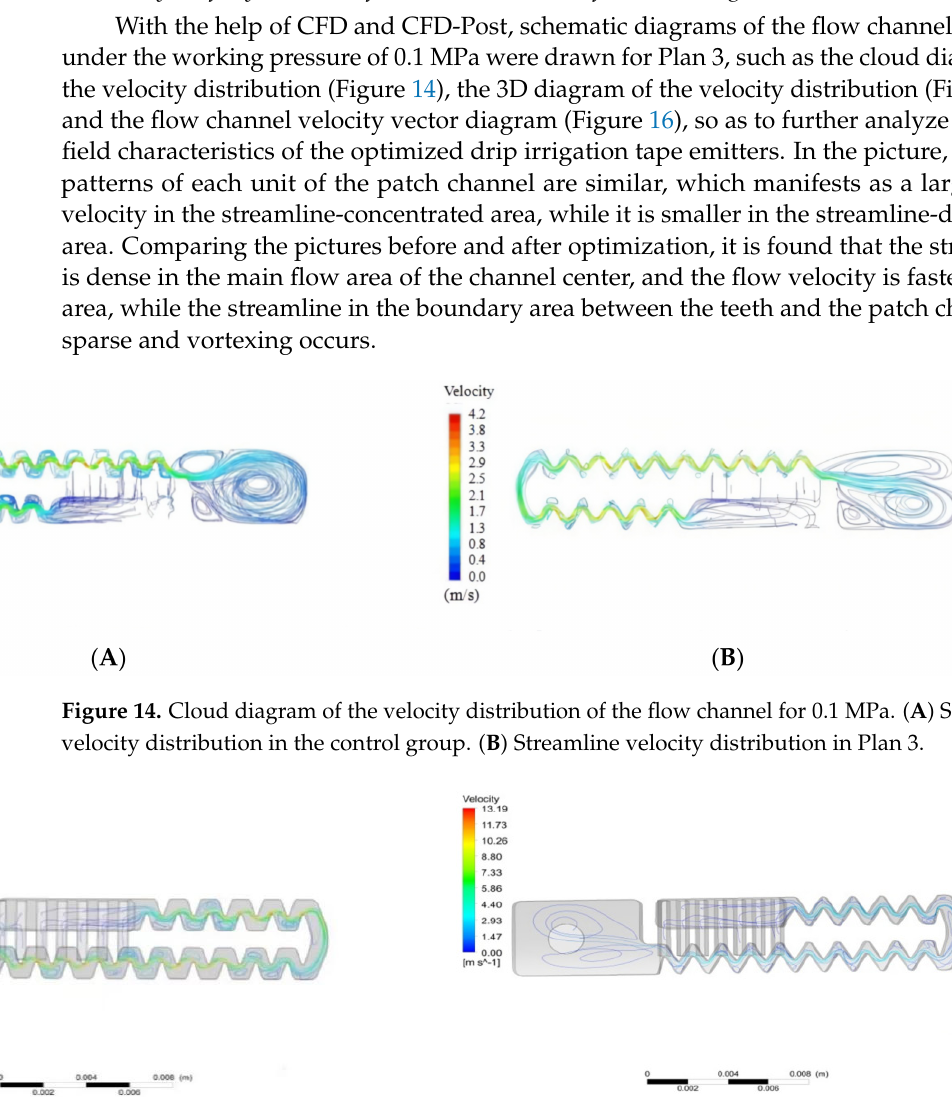
Figure 16. Velocity vector diagram of the flow channel for 0.1 MPa. ( A ) Control group (before opti- mization). ( B ) Plan 3 (after optimization). 5.4. A Summary of Performance Analysis for New Designed Emitters From the analysis of the hydraulic performances and energy dissipation perfor- mances in the all plans, it could be found that the smaller the tooth spacing was, the better the hydraulic performance of the channel was, and the lower the energy dissipation per- formance. According to the comparison of the flow index and average flow rate of the emitters in the three plans, the decrease of the flow index was smaller than the increase of the average flow rate of the emitters in Plans 1 and 2, and the change ratios of the two param- eters were 1:3.21 and 1:2.56, respectively, while it was 1.16:1 in Plan 3. This reflects that the improvement of hydraulic performance was greater than the reduction of the energy dissipation performance. Therefore, Plan 3 was the best in all plans. In other words, flow channel 2 without a tooth base represented by Plan 3 had a better performance than flow channel 1 with a tooth base. 5.5. Discussion The structural parameters of the flow channel play a key role in the drip emitter per- formance [35–37]. In this article, the structural parameters that affect the hydraulic perfor- mance of the drip irrigation tape were analyzed by Principal Component Analysis (PCA). The results showed that the influence of each structural parameter was: tooth spacing > minimum channel width > tooth height > maximum channel width > tooth numbers > channel circumference > channel depth > tooth arc length, of which the influence of tooth